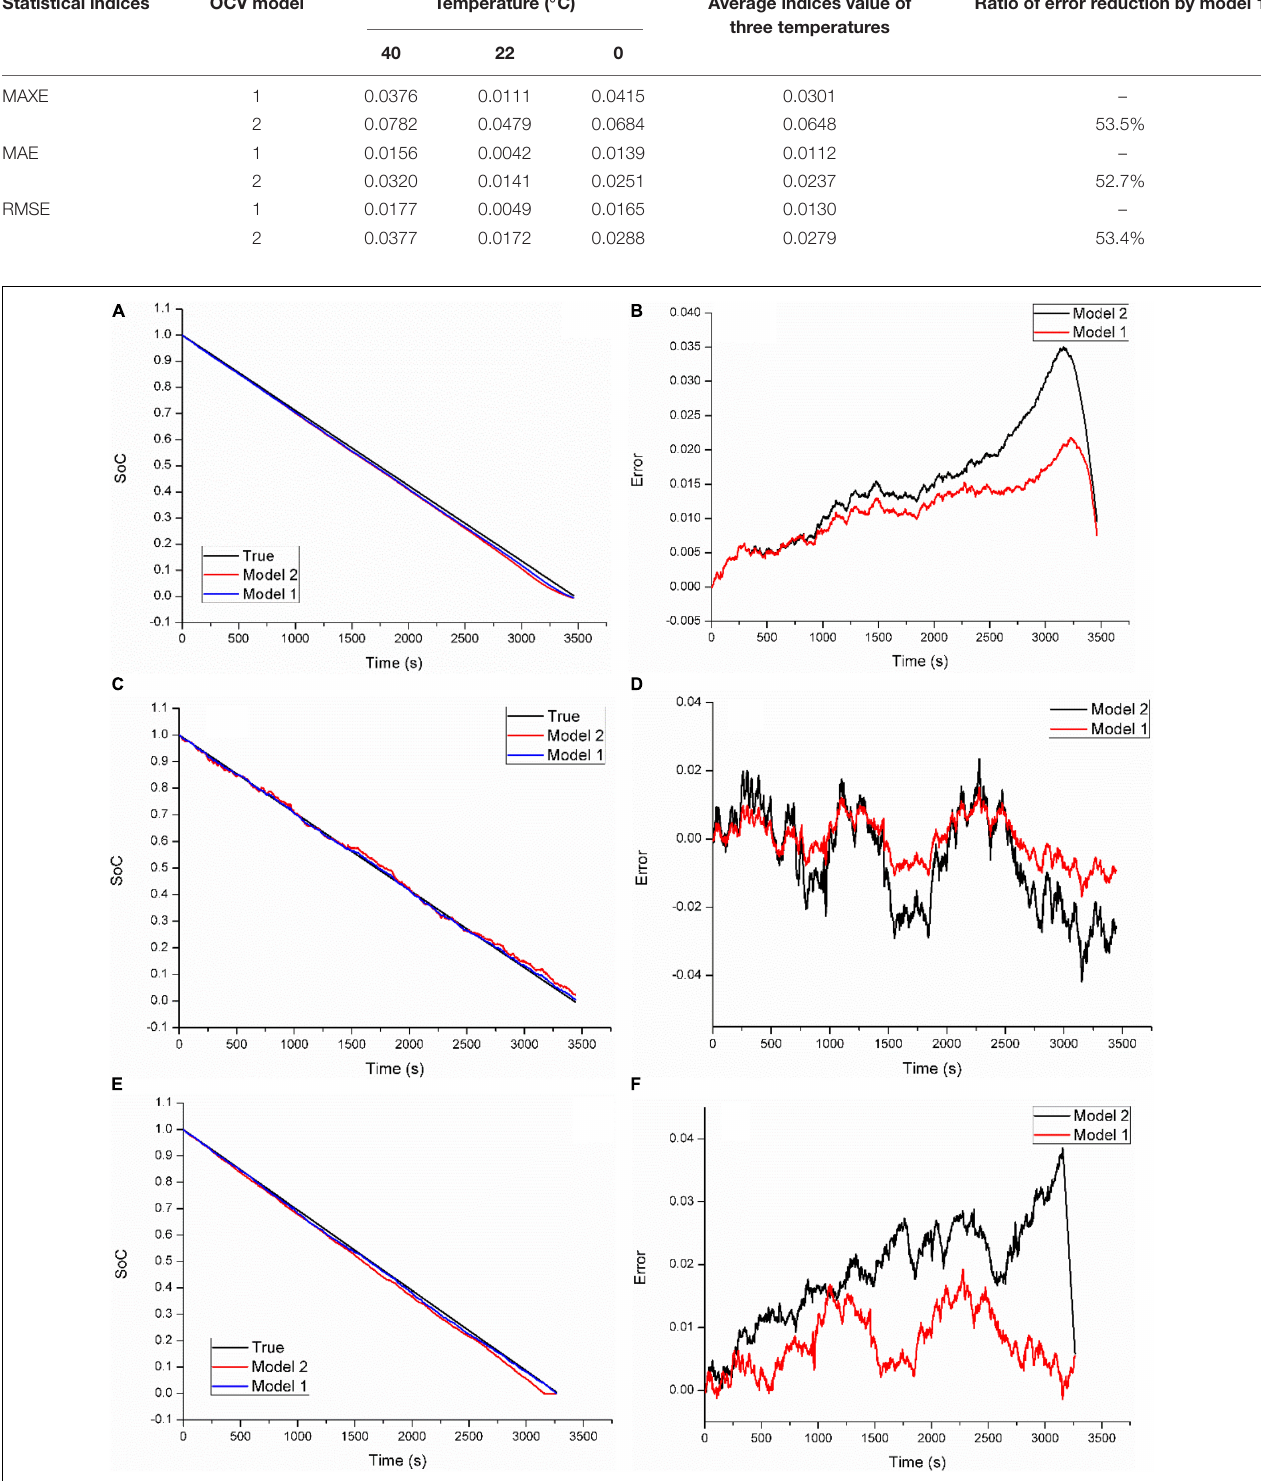
FIGURE 9 | Estimation results based on model 1 and model 2 at three temperatures via the CCD. (A) Estimated SoCs at 40 ◦ C; (B) estimation errors at 40 ◦ C; (C) estimated SoCs at 22 ◦ C; (D) estimation errors at 22 ◦ C; (E) estimated SoCs at 0 ◦ C; (F) estimation errors at 0 ◦ C.